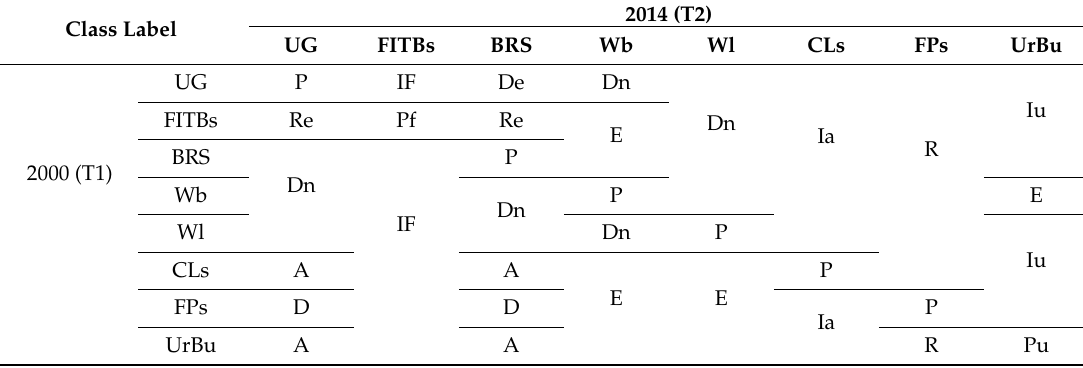
Table 3. LC conversion labels representing conversion trajectories between T1 and